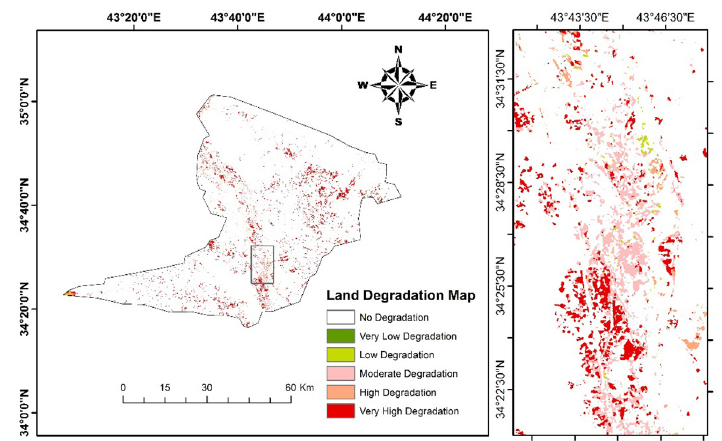
Figure 10. degradation map of Tikrit city